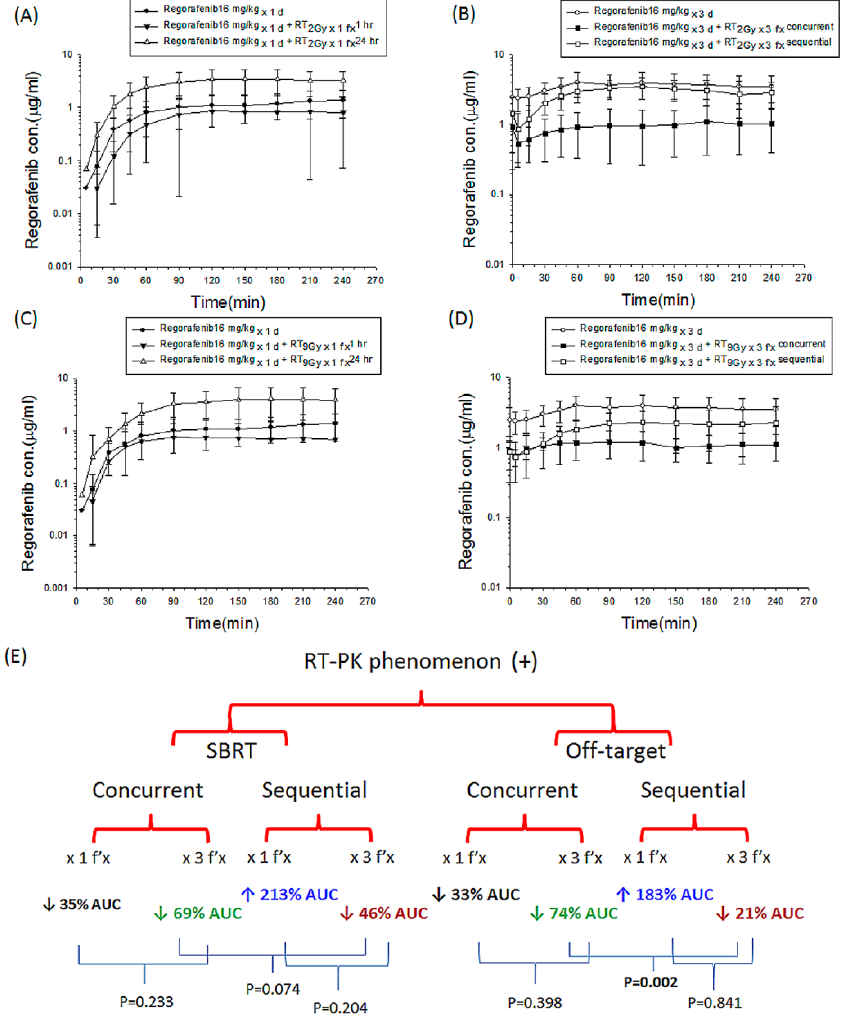
Figure 3. The concentration versus time curves of regorafenib in the plasma of rats obtained for different time courses with or without irradiation (RT). ( A ) The one fraction groups included a sham group, regorafenib with RT 0 Gy (regorafenib × 1 d); a concurrent group treated with regorafenib 1 h after RT 2 Gy with 1 fraction (RT 2 Gy × 1 f’x ); and a sequential group treated with regorafenib 24 h after RT 2 Gy × 1 f’x . ( B ) The multiple fraction treated groups included a sham group, regorafenib (p.o., q.d. × 3 d) with RT 0 Gy (regorafenib × 3 d); a concurrent group treated with regorafenib (p.o., q.d. × 3 d) 1 h after RT 2 Gy with 3 fractions (RT 2 Gy × 3 f’x ); and a sequential group treated